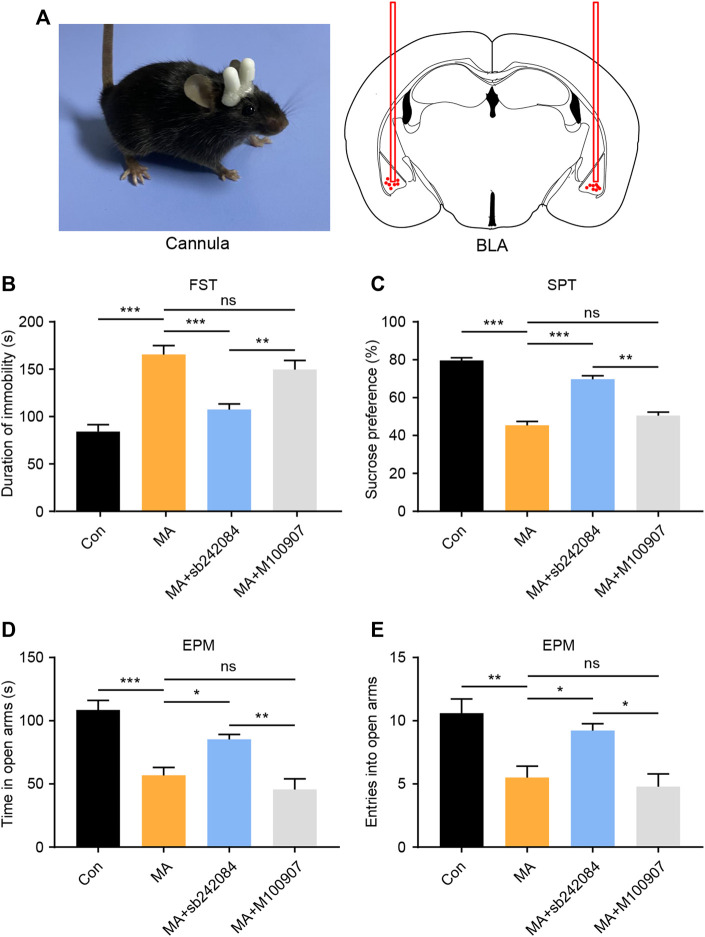
Pharmacological inhibition of 5-HT2CR reverses depressive and anxiety-like behaviors caused by chronic MA administration. (A) Schematic diagram of drug delivery strategy. (B) Immobility time during the FST after pharmacological intervention. (C) Sucrose preference in the SPT after pharmacological intervention. (D) Total time exploring the open arm of elevated plus maze. (E) Total entries into open arm of elevated plus maze. Data are presented as the mean ± SEM. *p < 0.05, **p < 0.01, ***p < 0.001.